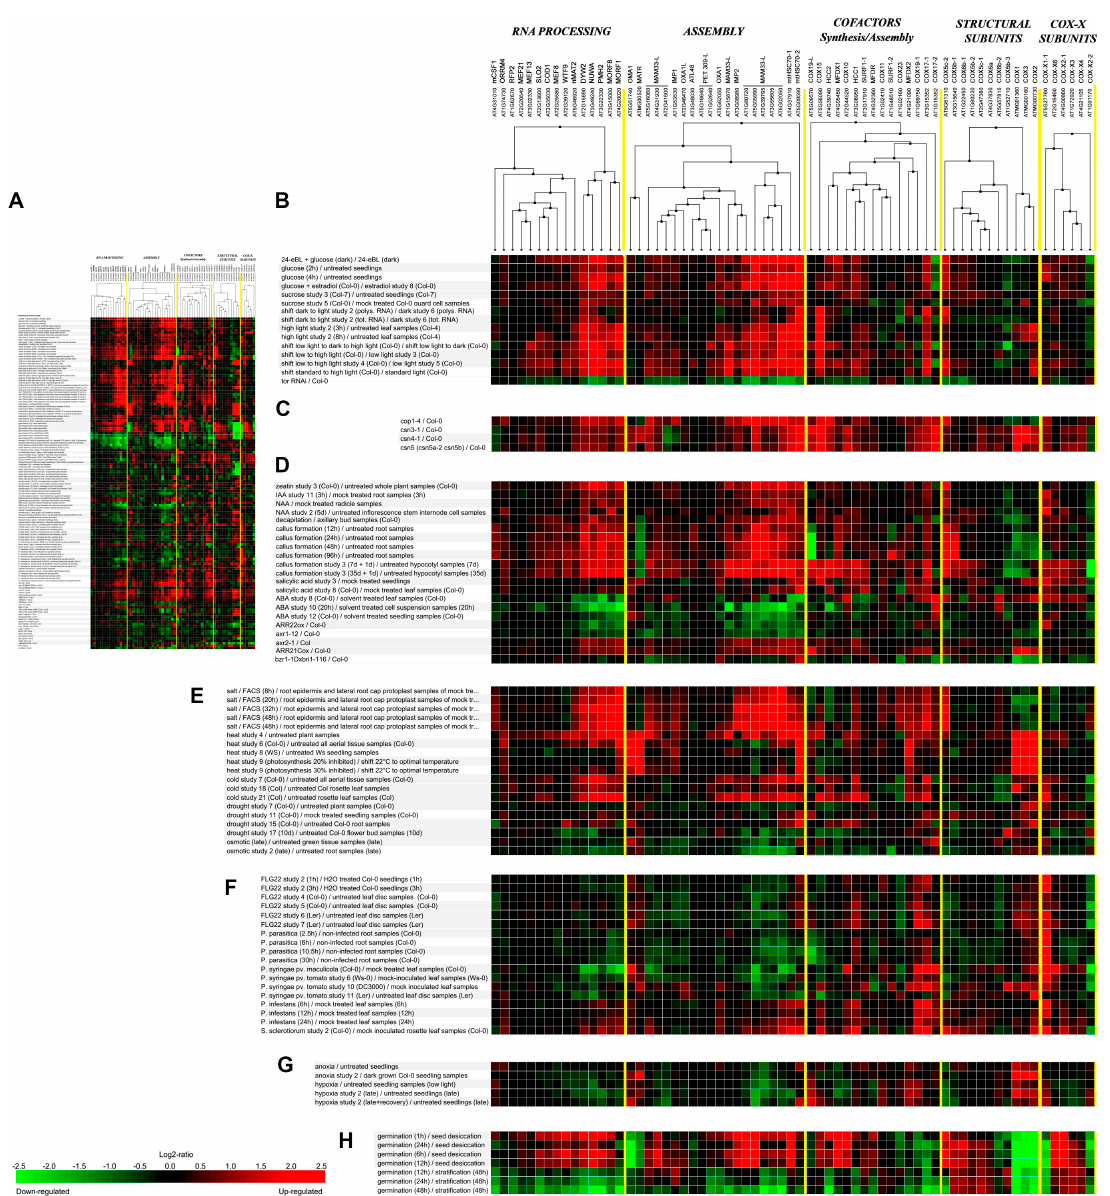
Figure 2. Meta-analysis of transcriptional data for genes encoding COX-related proteins in response to different perturbations or in several mutant backgrounds. ( A ) Complete hierarchical clustering of the expression data. A larger image is available in Figure S3. ( B – H ) Detail of specific parts of the clustering for transcriptional responses to nutrients and light ( B ); in mutants in members of the COP9 signalosome and the cop1-4 mutant ( C ); in response to hormones ( D ); abiotic stress ( E ); biotic stress ( F ); during oxygen deprivation ( G ); and during germination ( H ). Expression level is represented as log2-ratio of differential expression, in red for up-regulation and in green for down-regulation.